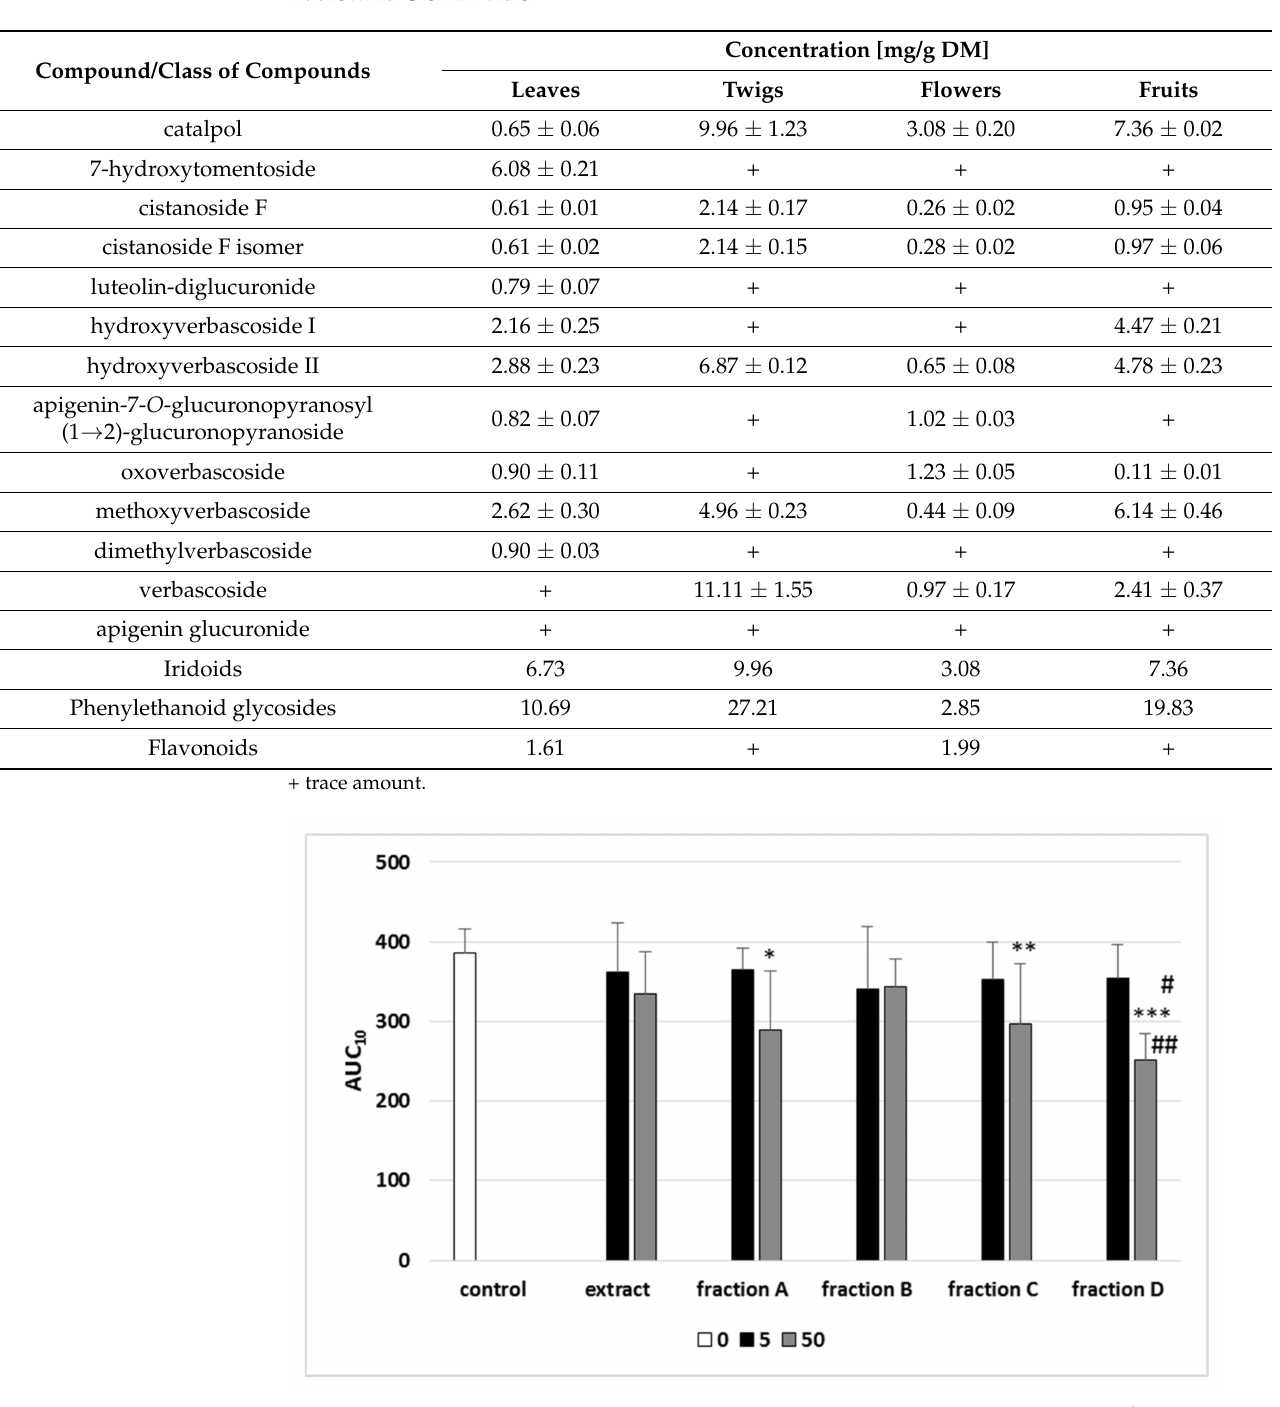
Figure 3. Effects of extract and four fractions (A–D) from Paulownia Clon In Vitro 112 ® leaves (5 and 50 µ g/mL; 30 min) on the T-TAS using the PL-chip in whole blood samples. Whole blood samples were analyzed by the T-TAS at the shear rates of 1000 s − 1 on the PL-chips. The area under the curve (AUC 10 ) in PL is shown. Data represent the means SD of six healthy volunteers. * p < 0.05 vs. control; ** p < 0.01; *** p < 0.001; # p < 0.01 (fraction D vs. fraction B); ## p < 0 05 (fraction D vs.